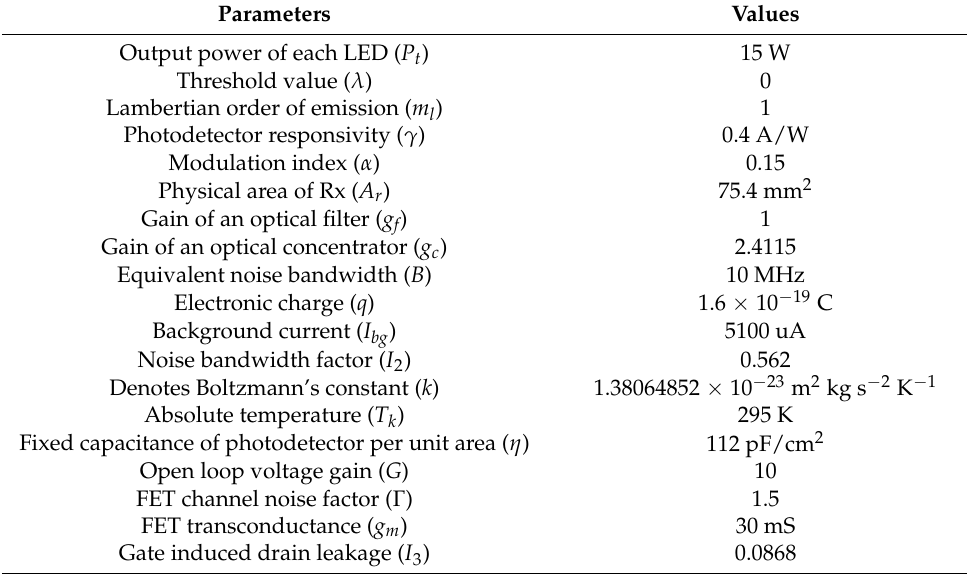
Table 1. Simulation